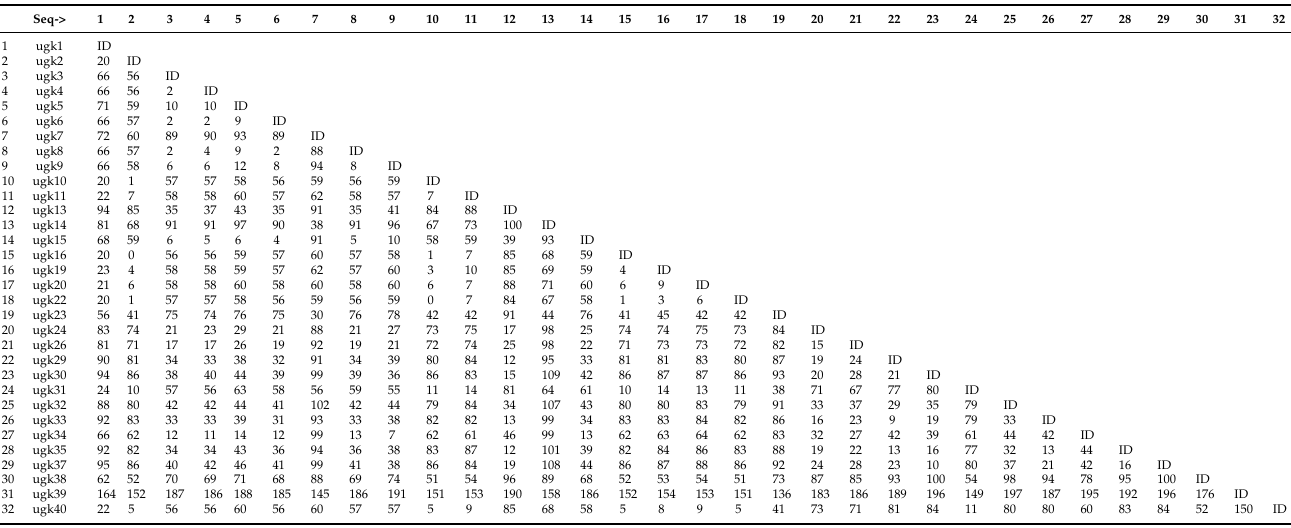
Table 3. Sequence differences based on pairwise sequence comparison of 28S rDNA gene between